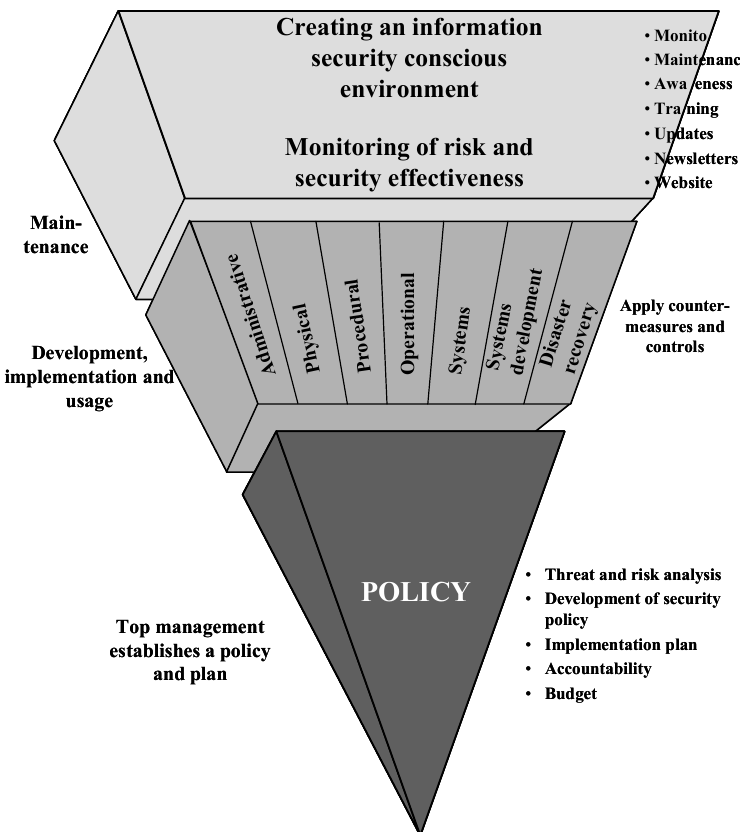
Figure 1: Framework for the management of information